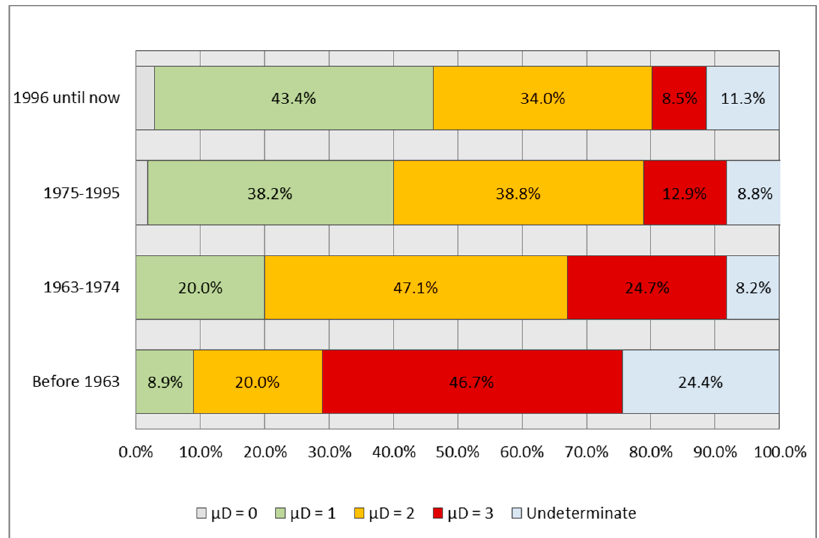
Figure 3. Distribution of the mean actual EMS-98 damage grade observed on RC buildings after the Lorca earthquake, 2011, according to the period of construction.